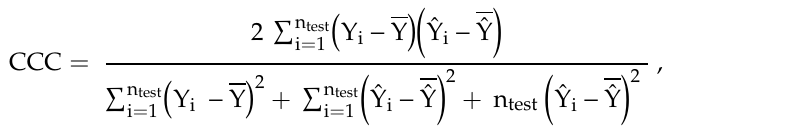
Table S1: Range of variability of descriptors for the training and test sets, Table S2: Results of the Y-randomization (30 shu ffl es) and the QUIK rule for the best model, Table S3: Intercorrelation matrix between any two descriptors and between one descriptor and a linear combination of all other descriptors, Table S4: Dataset compounds in SMILES format and respective MIC values ( µ M) and values of descriptors (values not